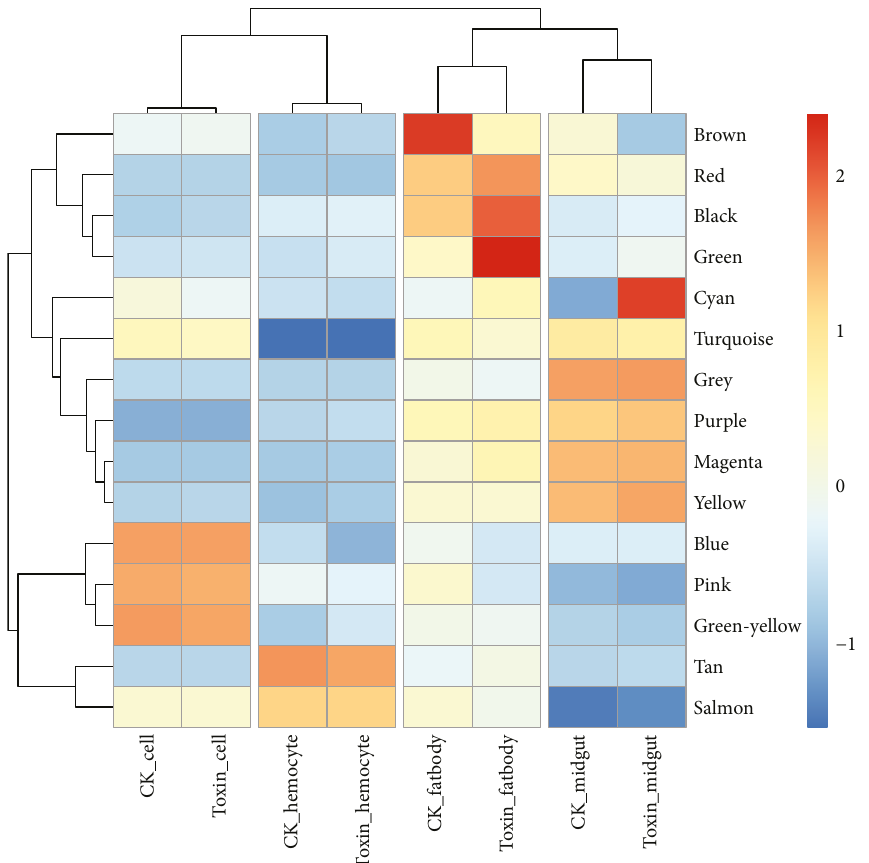
Figure 2: Heatmap plot of clustering result.